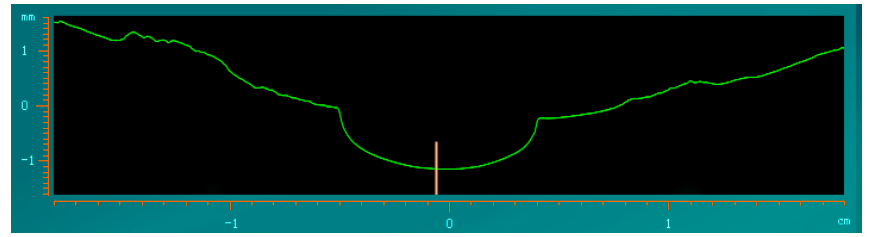
Figure 10. Morphology of magnetorheological polishing ribbon.